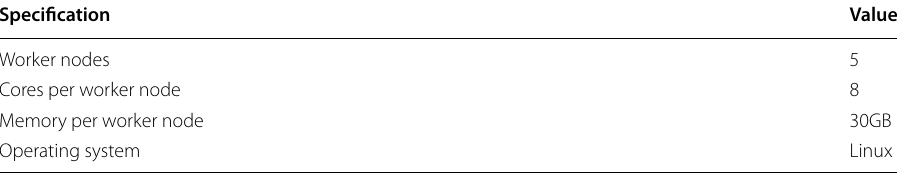
Table 3 Cluster